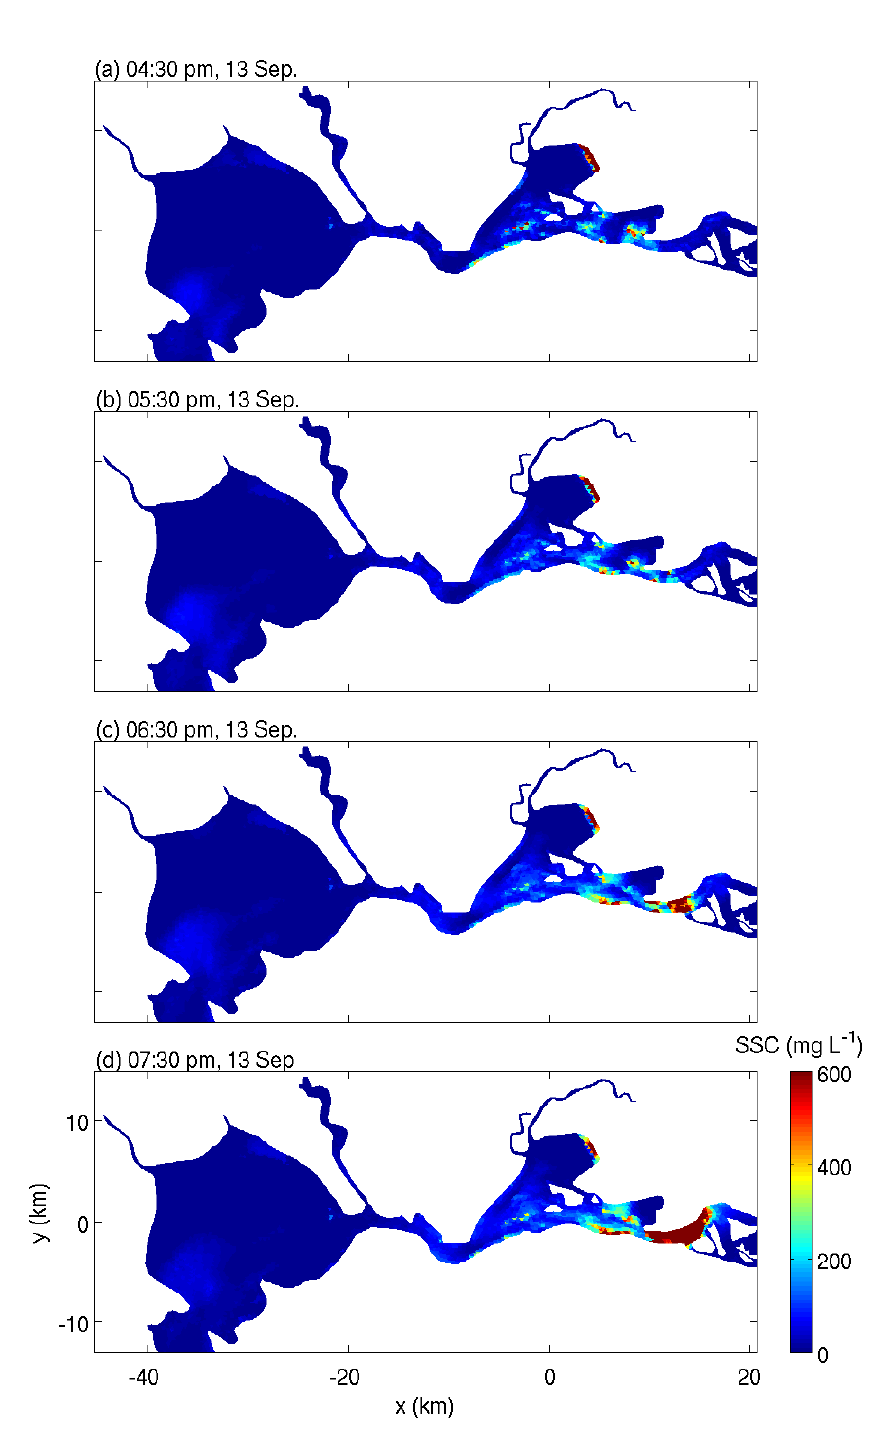
Figure 8. Representative snapshots of the near-surface SSC at 04:30 p.m. ( a ), 05:30 p.m. ( b ), 06:30 p.m. ( c ), and 07:30 p.m. ( d ) on 13 September 2009 predicted using the original resuspension formula without the present